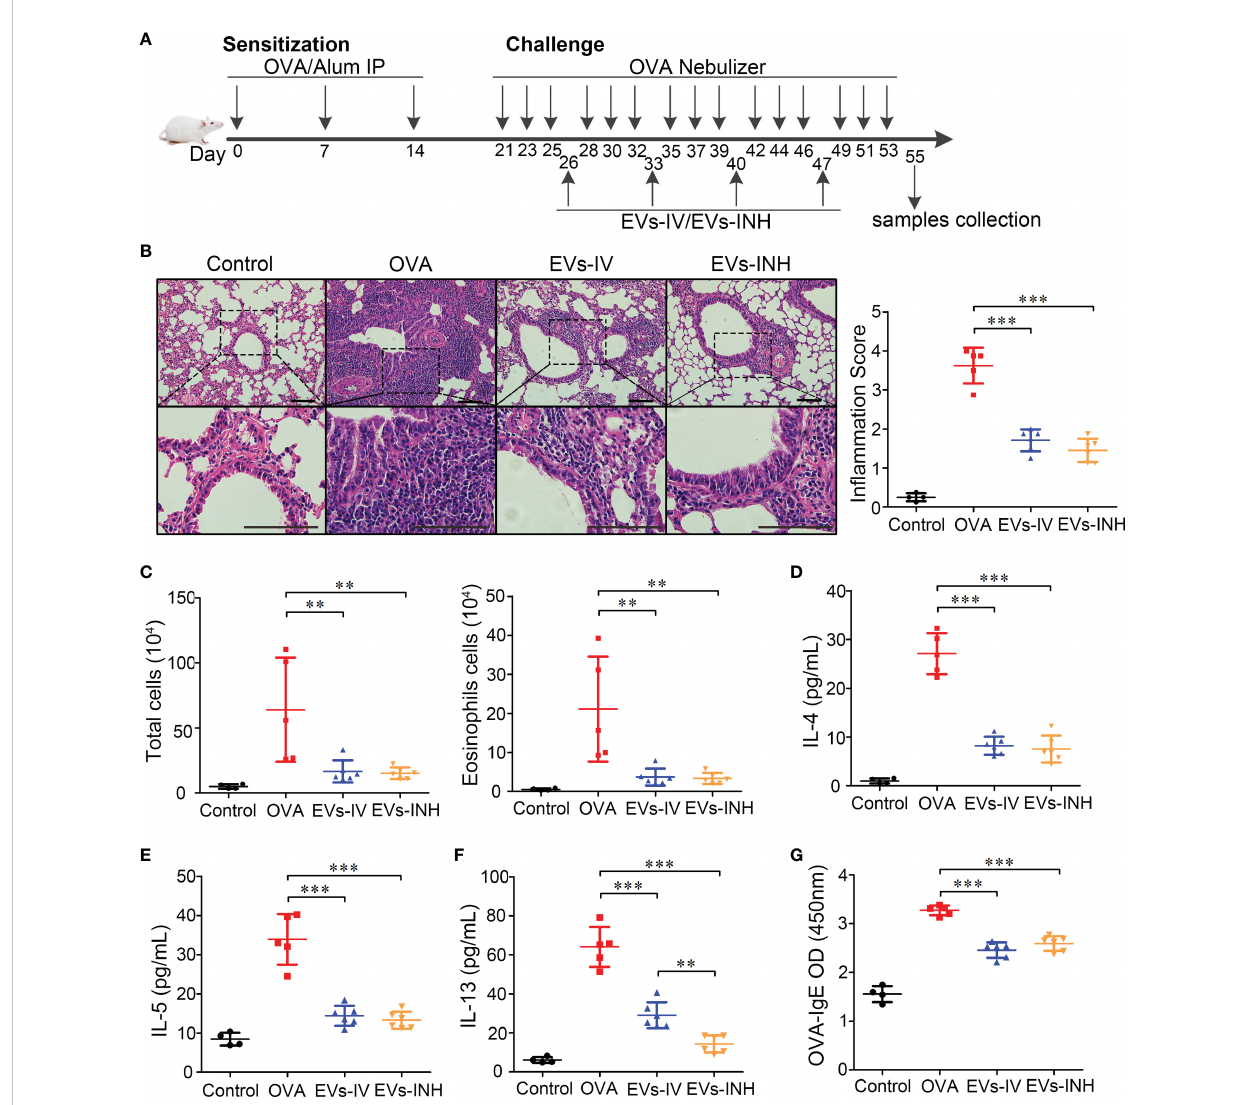
FIGURE 4 Inhalation of nebulized Hypo-EVs attenuated OVA-induced chronic airway in fl ammation in mice. (A) Experimental protocol for the development of chronic allergic asthma and treatment with Hypo-EVs. (B) Representative photographs of HE stained lung sections from each group (black bar =100 m m), the images are shown at ×200 (up panel) and ×400 (down panel), and the in fl ammatory in fi ltration was quanti fi ed by in fl ammation score. (C) Statistical analysis of the total in fl ammatory cells and eosinophils in the BALF. (D – F) IL-4, IL-5 and IL-13 levels in the BALF were measured by using ELISA. (G) The levels of OVA- speci fi c IgE levels in serum were analyzed using ELISA. EVs-INH, Hypo-EV nebulization inhalation; EVs-IV, Hypo-EV intravenous injection. Each dot represents data from one animal and n = 4-6 per group. One-way analysis of variance (Tukey Kramer post hoc tests): ** P < 0.01, *** P <